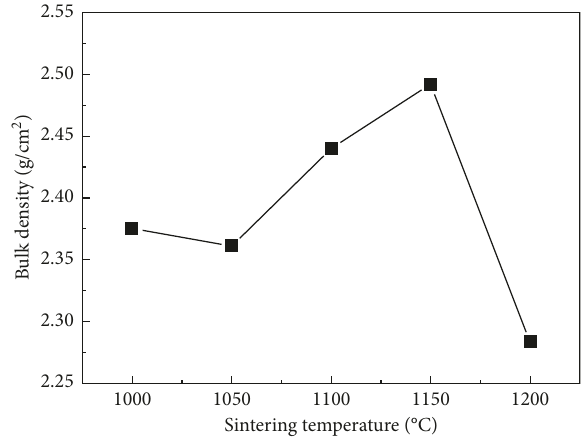
Figure 2: The variation of bulk density of (Mg 12% B 2 O 3 –LiF sintered at (a) 1000 ° C, (b) 1050 ° C, (c) 1100 ° C, (d) 1150 ° C, and (e) 1200 °